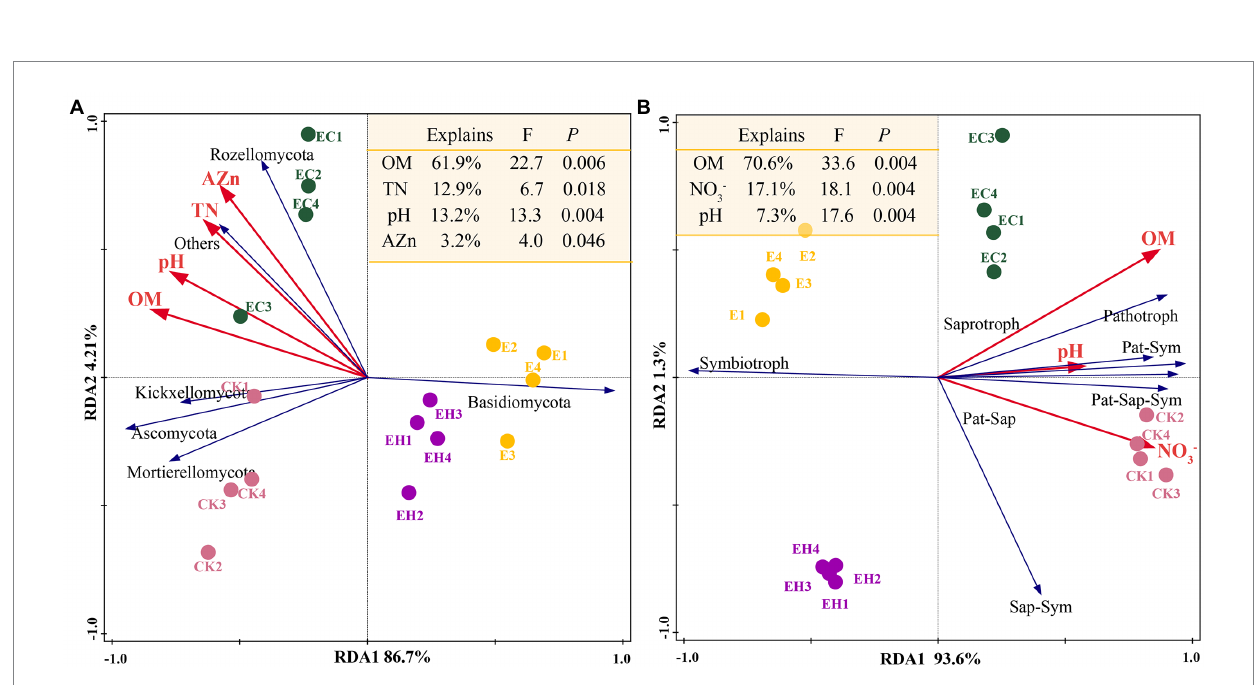
FIGURE 7 Effect of soil chemistry on fungal community composition and function. Redundancy analysis reveals the relationship between environmental factors and fungal community composition (A) or fungal trophic patterns (B) . OM, soil organic matter; TN, total nitrogen; TP, total phosphorus; NO¯ 3_N, nitrate nitrogen; NH+ 4_N, ammonium nitrogen; AP, available phosphorus; AZn, available zinc; ACa, available calcium; Sap-Sym, saprotroph- symbiotroph; Pat-Sap, pathotroph-saprotroph; Pat-Sym, pathotroph-symbiotroph; Pat-Sap-Sym,